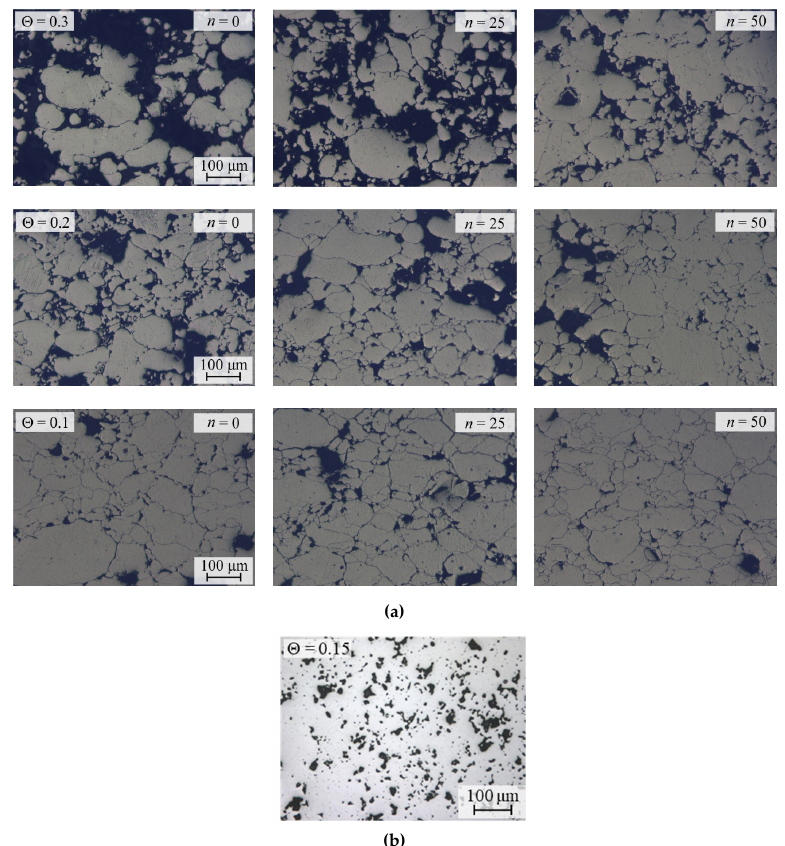
Figure 5. Micrographs showing the porosity distribution for ( a ) different discharges of the specimen with initial porosities of 0.3, 0.2, and 0.1, and ( b ) the conventionally sintered compact. The fracture surfaces of mechanically broken specimens were studied to observe the bonds or necks between particles after the discharges. Figure 6 shows the fracture surface after a different number of discharge cycles in the specimens with an initial porosity of 0.3, 0.2, and 0.1. For Θ = 0.3 and after five discharges, weak bonds start to appear between particles, being easily broken. Necks seem to get more and more stable with the number of discharges, up to form good bonds revealed by the appearance of features characteristic of a ductile behavior, as shown for 30 discharges. In addition, the high temperature reached in some contacts seem to reveal the melting and quenching generated by the Joule heat, observing a colony of microparticles adhered to the surface, as described for tung- sten powder in [58]. Therefore, for an initial high porosity, the powder column has a high